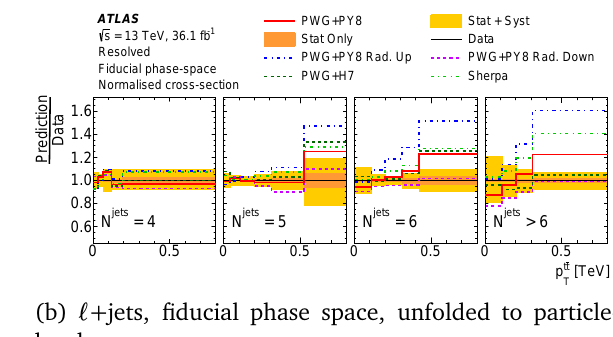
(b) (cid:96) + jets, fiducial phase space, unfolded to particle- level.